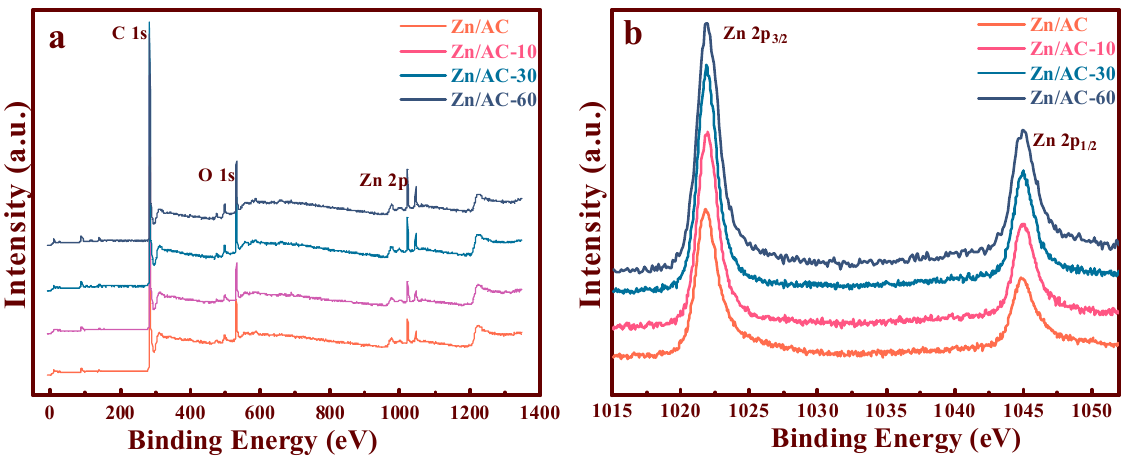
Figure 6. XPS spectra of the synthesized Zn/AC-x catalysts: ( a ) wide survey spectra; ( b ) Zn 2p region.